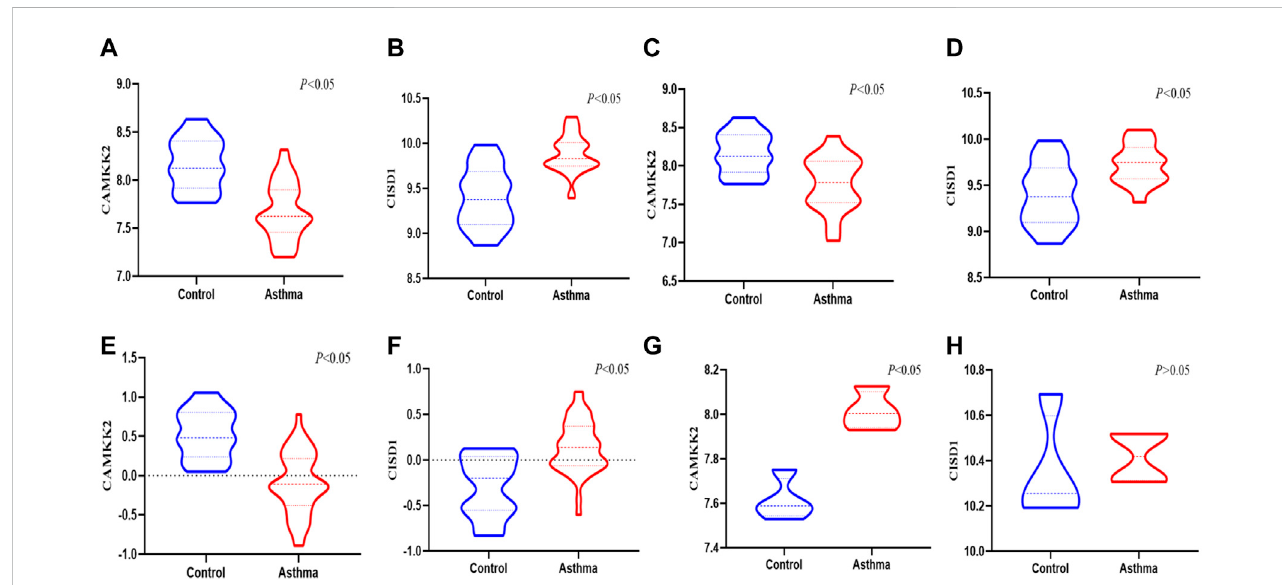
FIGURE 5 The validation of CAMKK2 and CISD1 in the GEO datasets (A,B) the expression of CAMKK2 and CISD1 in the severe asthma were veri fi ed in GSE 147878 ( p < 0.05) (C,D) TheexpressionofCAMKK2andCISD1inthemild/moderateasthmawereveri fi edinGSE147878( p < 0.05) (E,F) TheexpressionofCAMKK2and CISD1 in the severe asthma were veri fi ed in GSE 143303( p < 0.05) (G,H) The expression of CAMKK2 and CISD1 were veri fi ed in GSE 27066 ( p < 0.05)